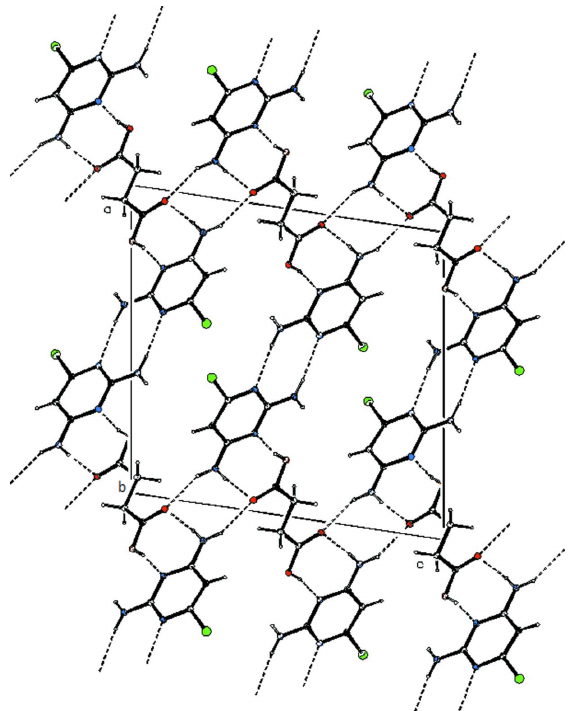
Figure 2 Partial packing diagram of the title compound showing hydrogen bonds as dashed lines.